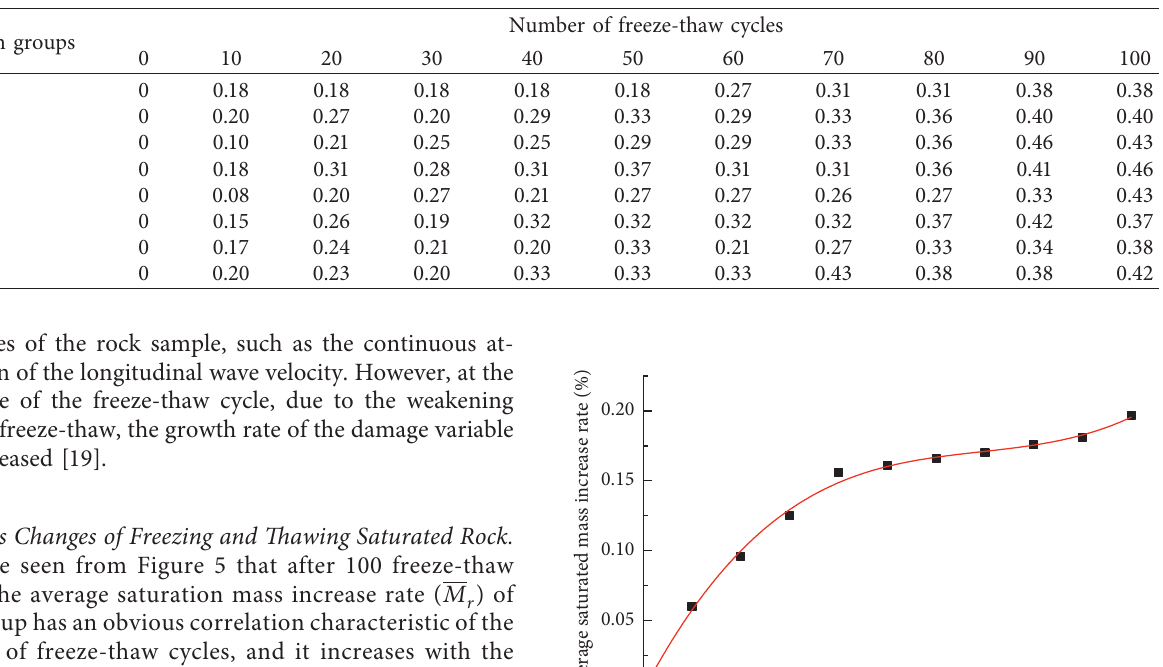
Table 1: Rock damage variables and freeze-thaw times.